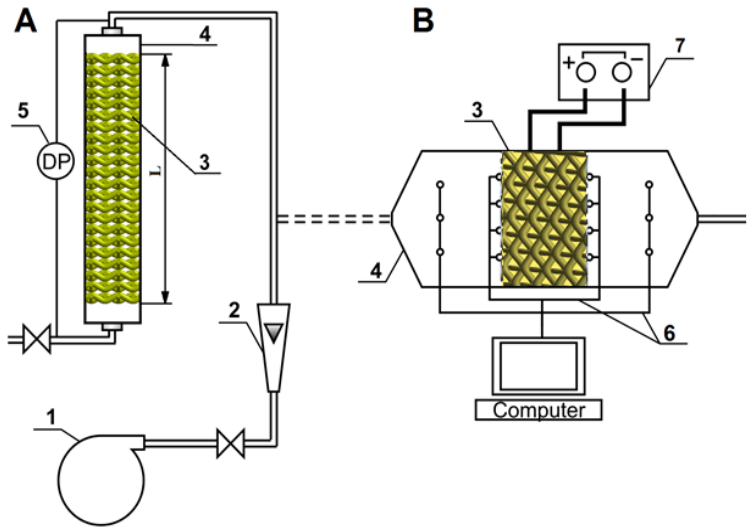
Figure 3. Experimental apparatus for pressure drop ( A ) and heat transfer ( B ) measurements: 1—blower; 2—flowmeter; 3—wire gauze; 4—test reactor; 5—manometer; 6—thermocouples; 7—electric current.